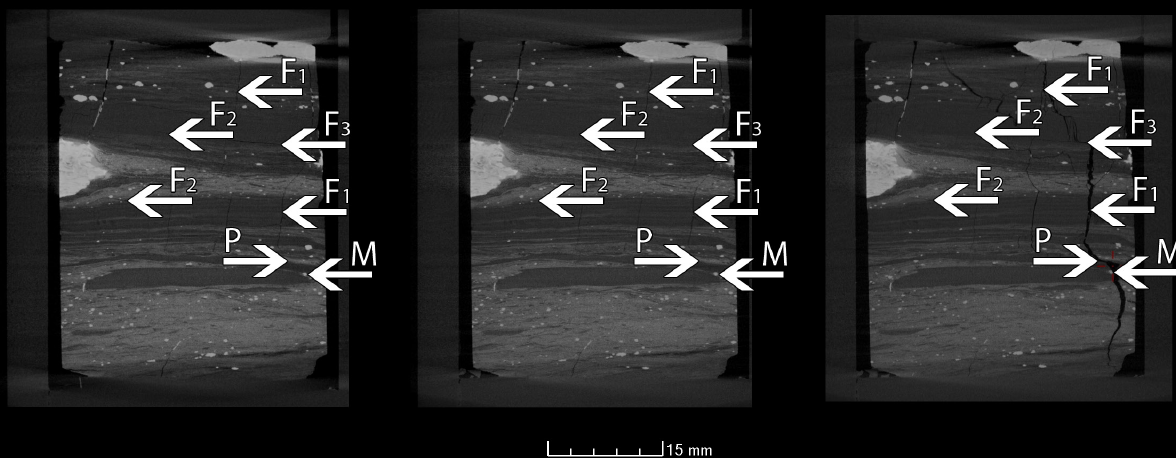
F indicates cleats or cracks that existed in the pre-loaded particles that enlarged during compression; M indicates mineral inclusions that may have had an influence on either crack initiation or crack propagation; P indicates either maceral–maceral boundaries or maceral–mineral boundaries that may have had an influence on crack initiation. Figure 4: Comparison of a particle before (left) and after (right) compression incrementally perpendicular to the bedding